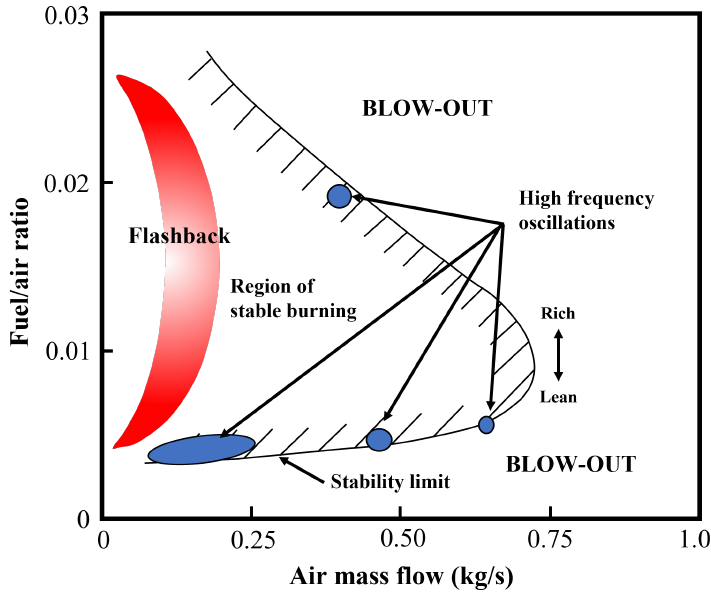
Figure 20. Combustion operability for gas turbine based on air fuel ratio over the air mass